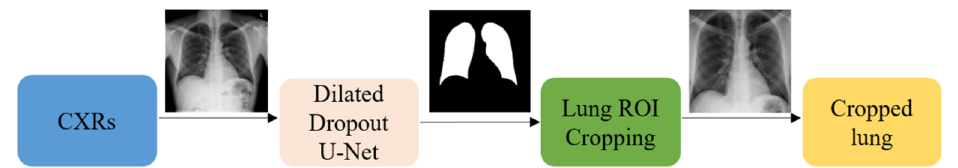
Figure 3. The segmentation approach showing dilated dropout U-Net-based mask generation and lung ROI cropping.